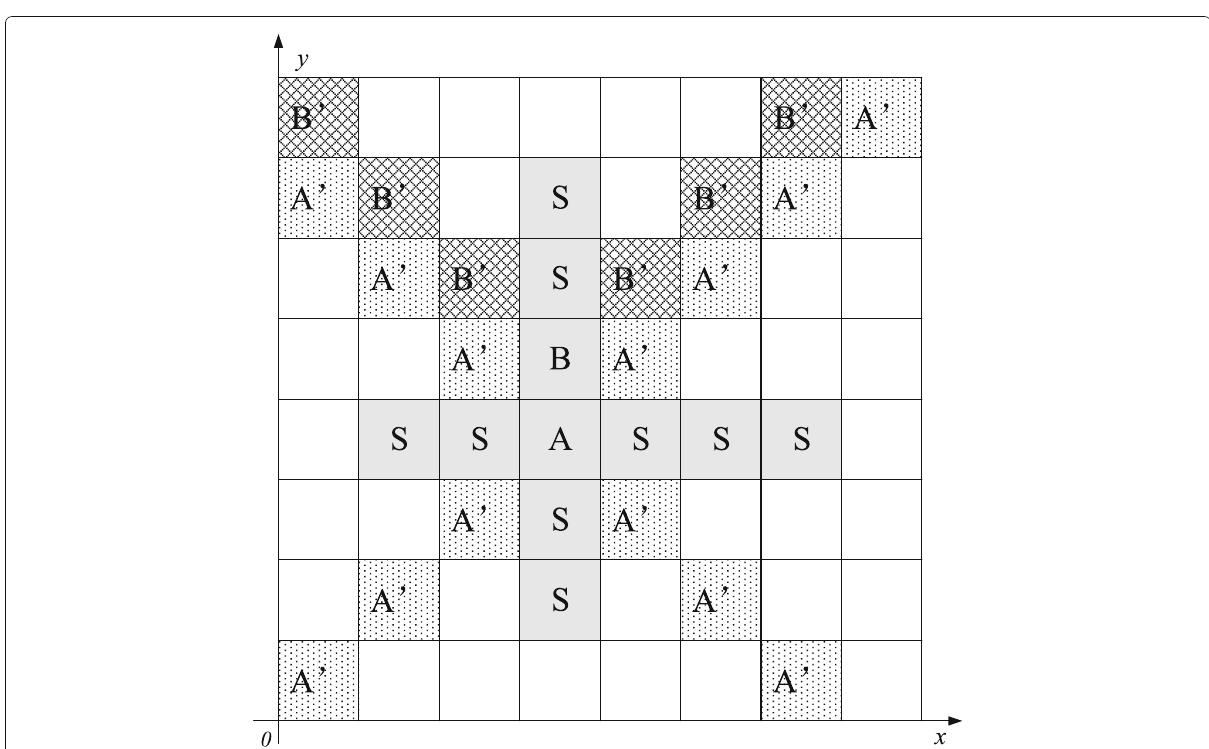
Fig. 8 The moving belt grids and corresponding responsible areas. S , A , and B are the moving regions of mobile sink in one moving cycle. A (cid:4) represents the region which grid A is responsible for and B (cid:4) represents the region which grid B is responsible